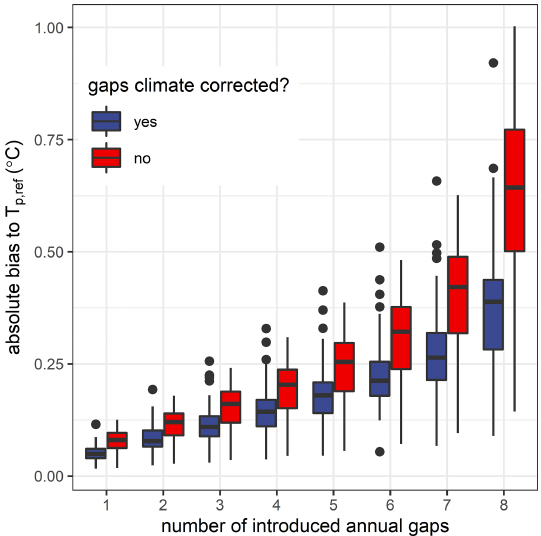
Figure 2. Improvement in absolute bias of thermal peaks across all reference sites ( T p , ref ; n = 30) when introduced annual gaps were filled with the climate correction procedure ( | T p , fill − T p , ref | , red boxplots) compared to when gaps were unfilled ( | T p , gap − T p , ref | , blue boxplots), regardless of the number of introduced